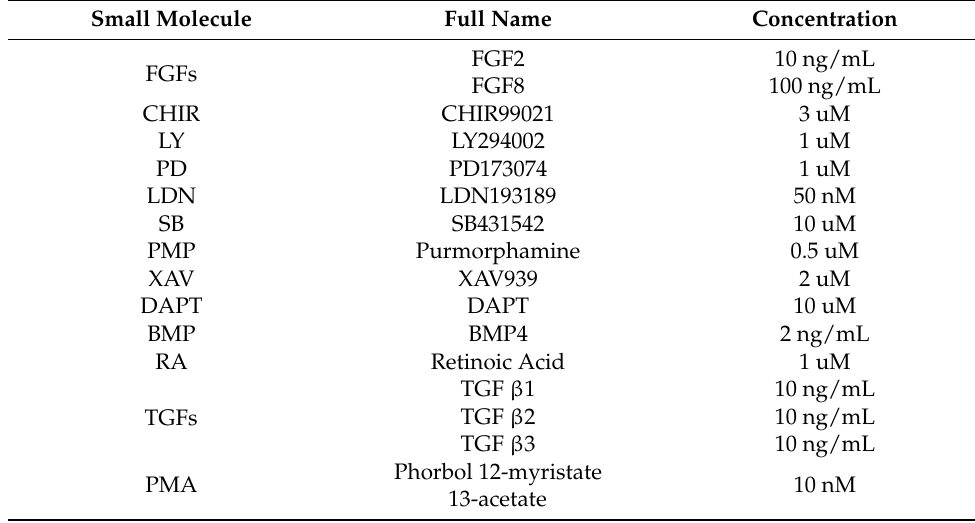
Table 1. The list of small molecules for myotube